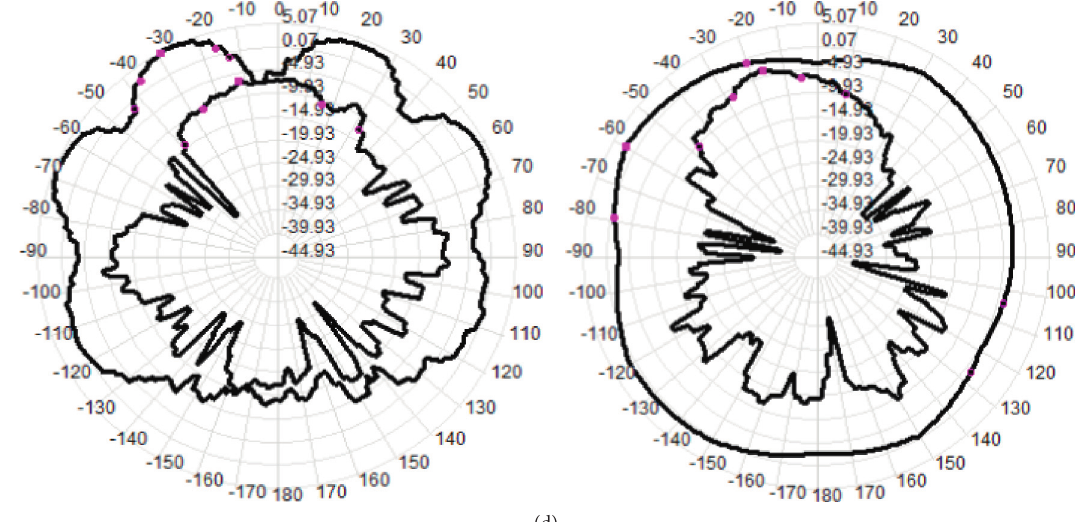
Figure 15: E/H-plane radiation patterns at (a) 1.6GHz, (b) 2.35GHz, (c) 3.8GHz, and (d) 5.85GHz.